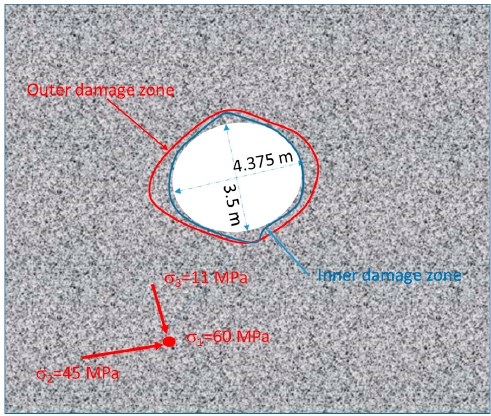
Figure 10. Excavation Damage around the Tunnel Sealing Experiment (TSX) tunnel (adapted from Chandler et al.